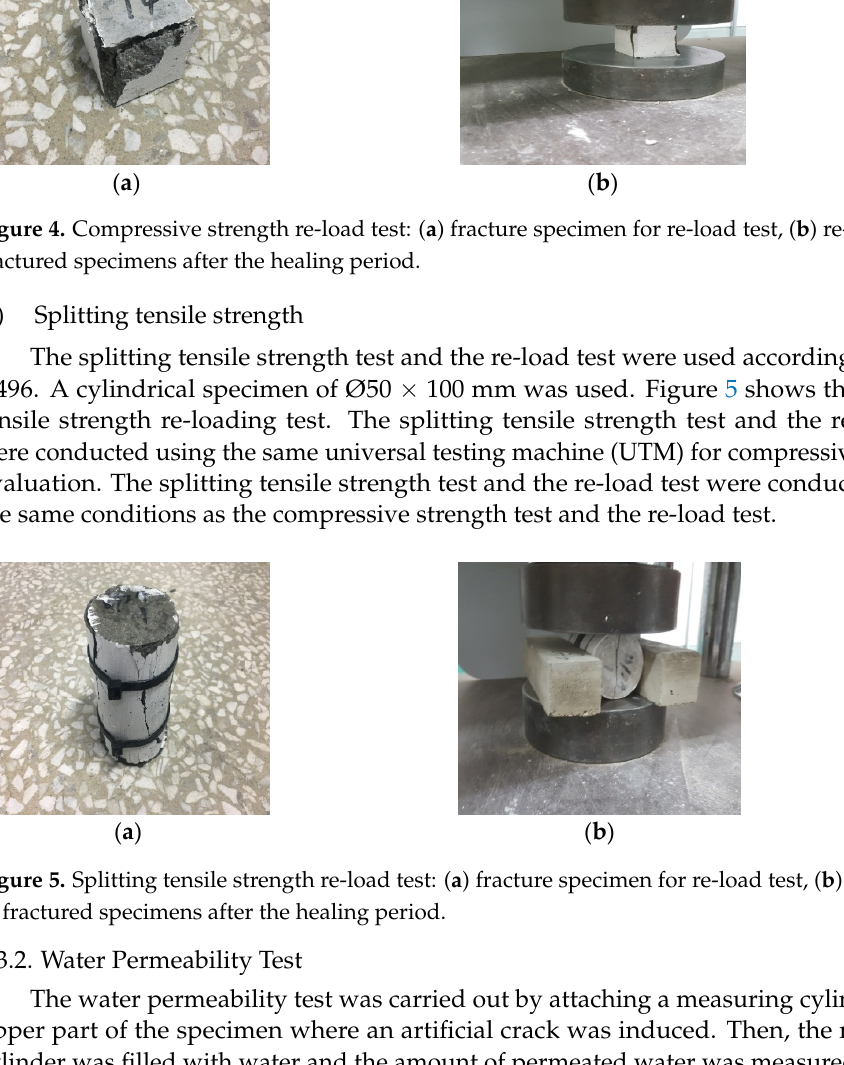
Figure 4. Compressive strength re-load test: ( a ) fracture specimen for re-load test, ( b ) re-load test of fractured specimens after the healing period.